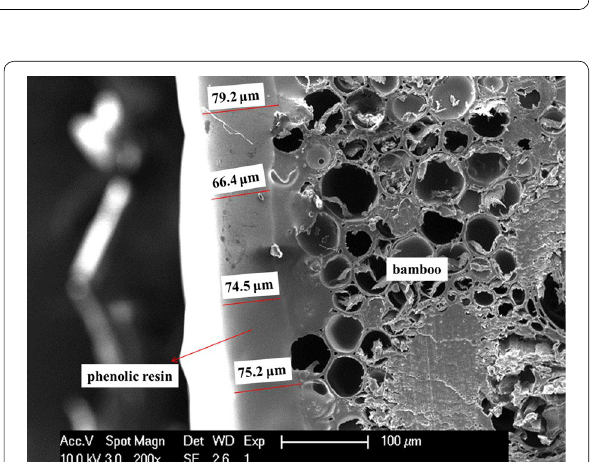
Fig. 1 Schematic of glued bamboo strips sample